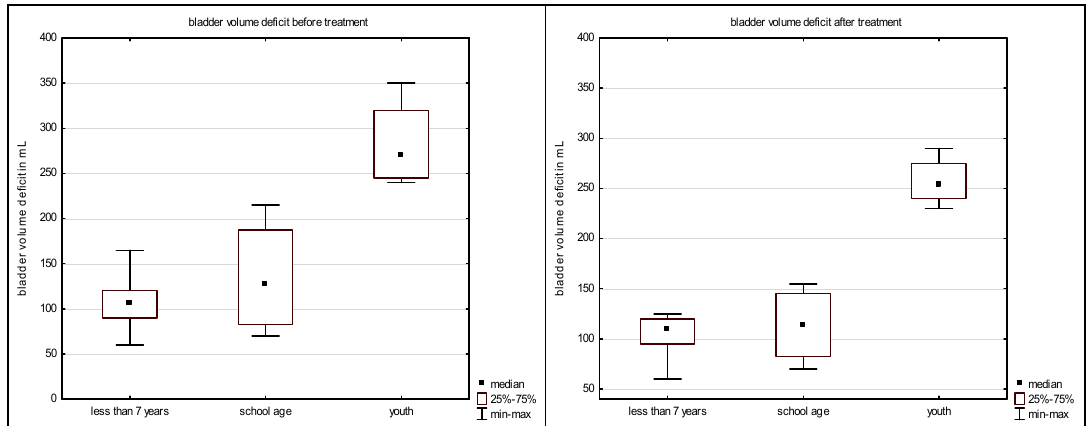
Figure 1. The difference between the expected and measured bladder volume in the investigated children.